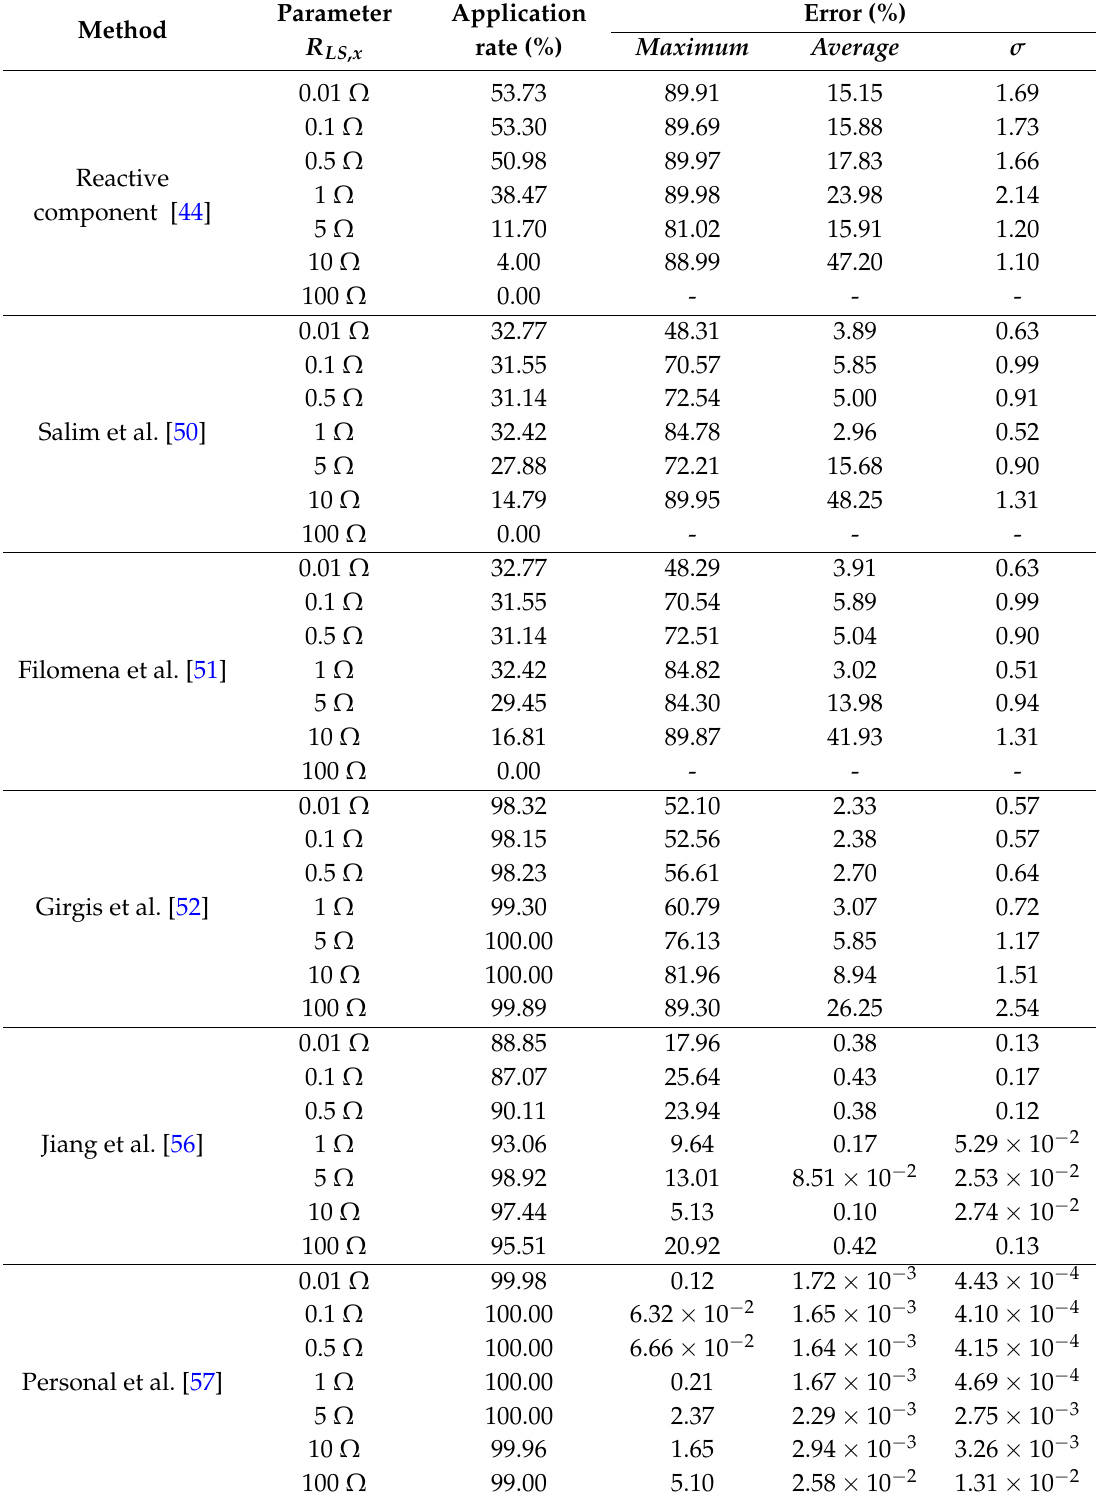
Table A5. Line-to-sheath resistance